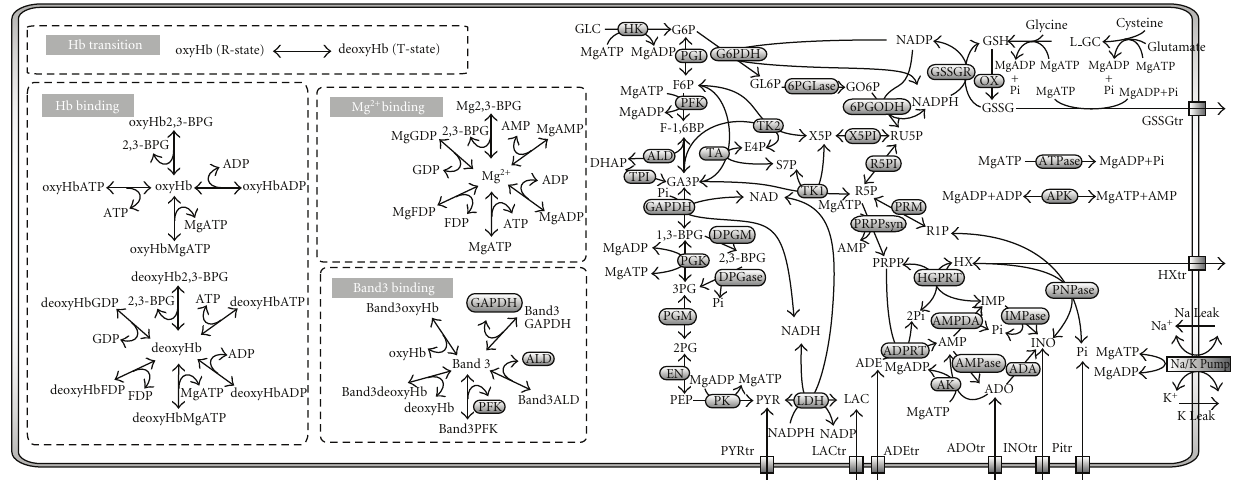
Figure 2: A Metabolic pathway map constructed using the E-Cell RBC model. The complete reaction network of the metabolism in the E-Cell RBC model. MgX/oxyHbX/deoxyHbX/band3X denotes the complex formed by compound “X” and Mg 2+ , oxyhemoglobin, deoxyhemoglobin, or band 3, respectively. Abbreviations used in this figure: GLC, glucose; G6P, glucose-6-phosphate; F6P, fructose-6- phosphate; F1,6-BP, fructose-1,6-bisphosphate; DHAP, dihydroxyacetone phosphate; GA3P, glyceraldehyde-3-phosphate; 1,3-BPG,